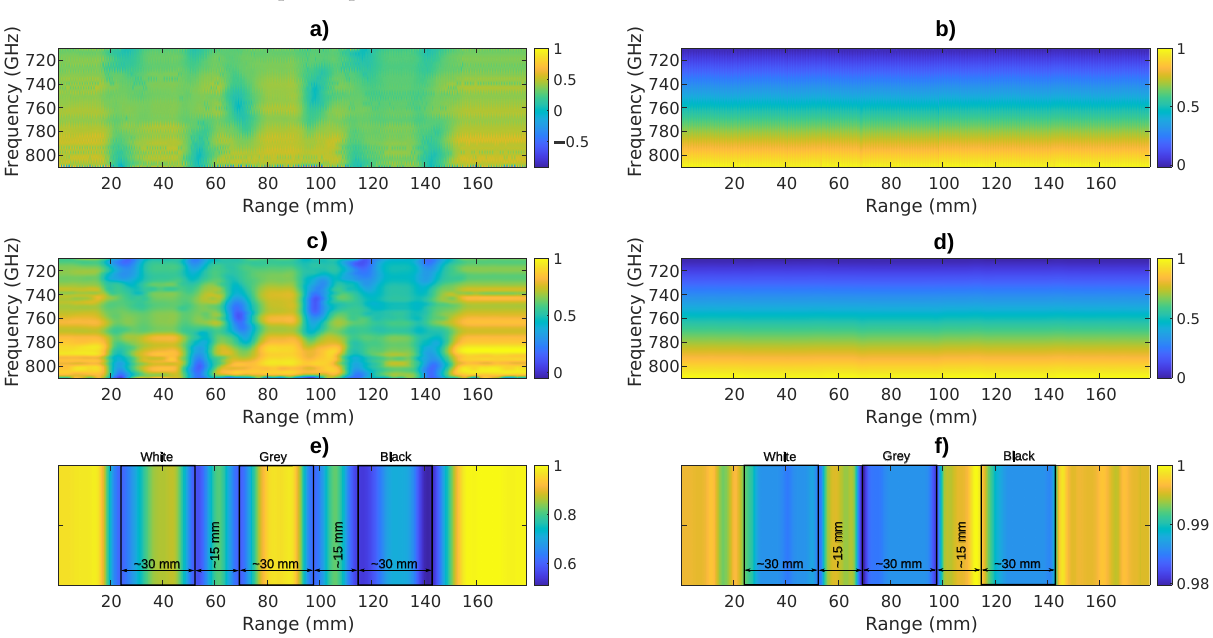
Figure 14. Spectrograms and images for acquisition in the frequency range 710–810 GHz: ( a ) Peak envelope spectrogram. ( b ) Unwrapped phase spectrogram. ( c ) Peak envelope spectrogram processed using GSF. ( d ) Unwrapped phase spectrogram processed using GSF. ( e ) Compressed 1D intensity image with marked plastic plates’ positions. ( f ) Compressed 1D phase image with marked plastic plates’